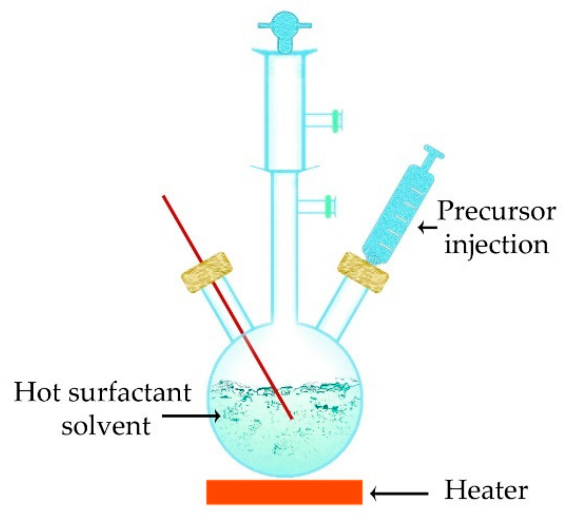
Figure 7. Hot-injection flask.